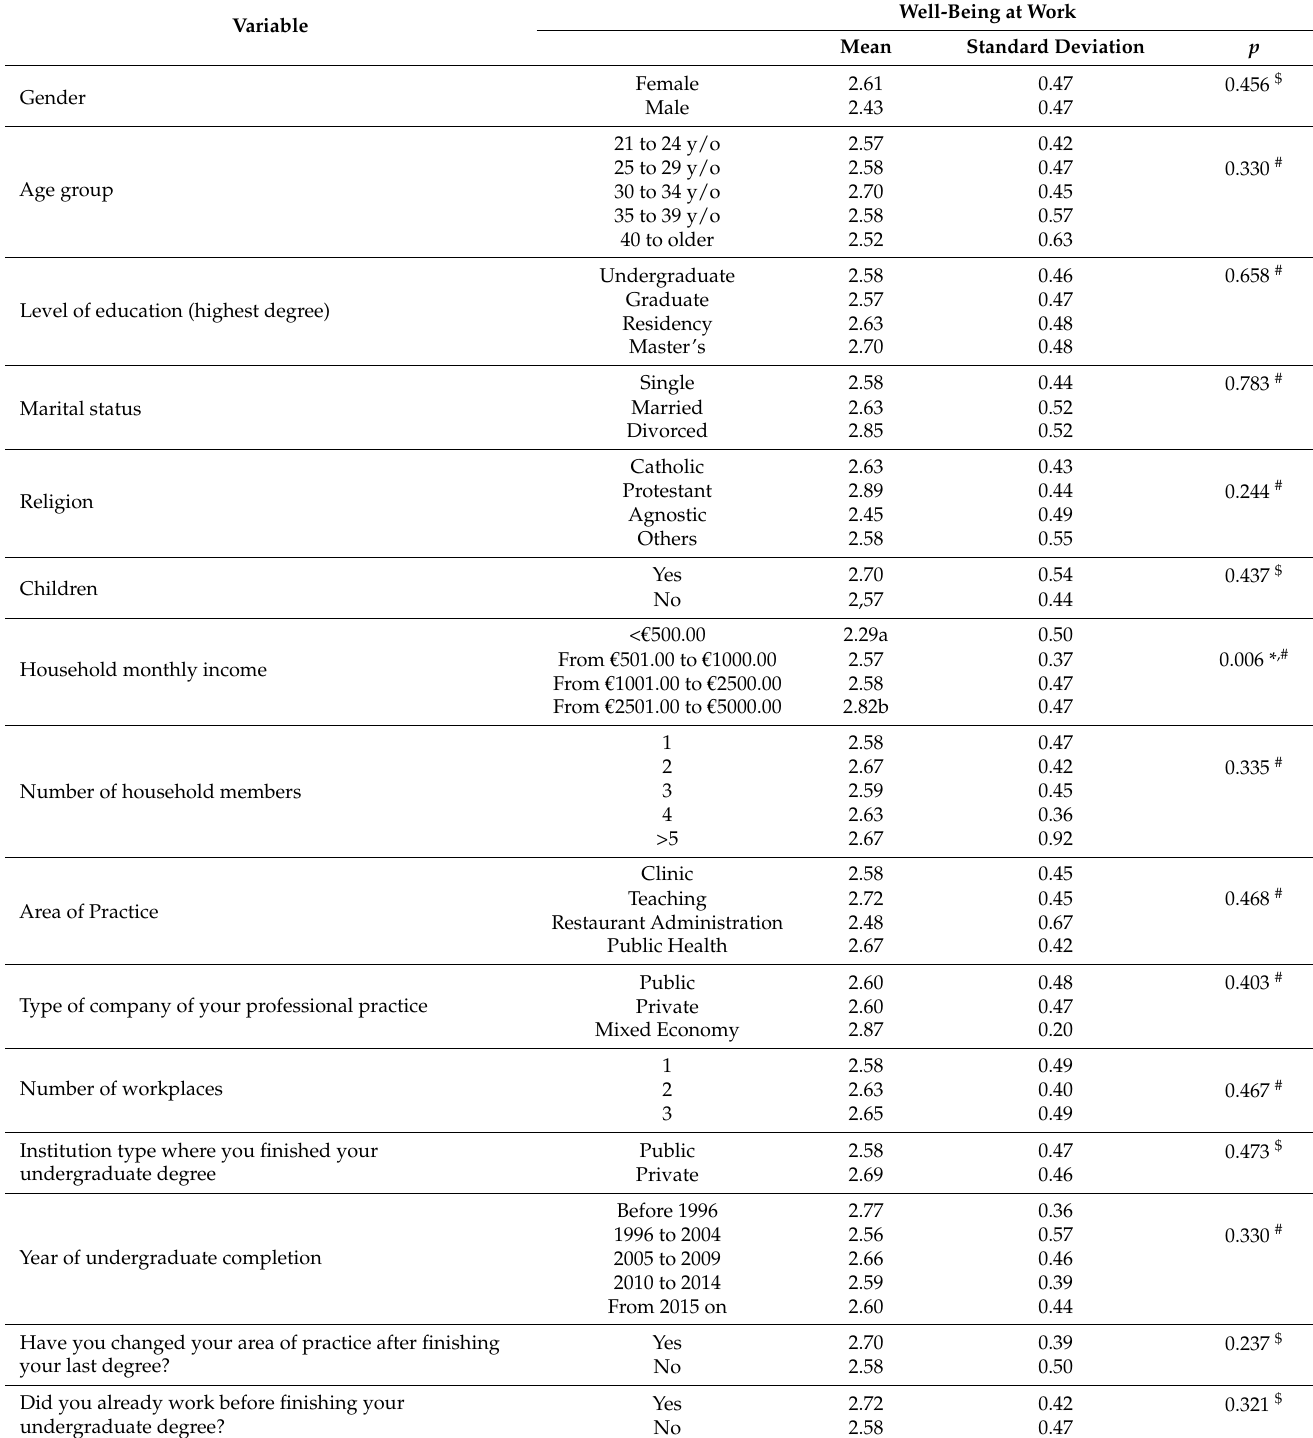
Table 2. Variance analysis of well-being at work and of socioeconomic and demographic variables of Portuguese nutritionists. Variable